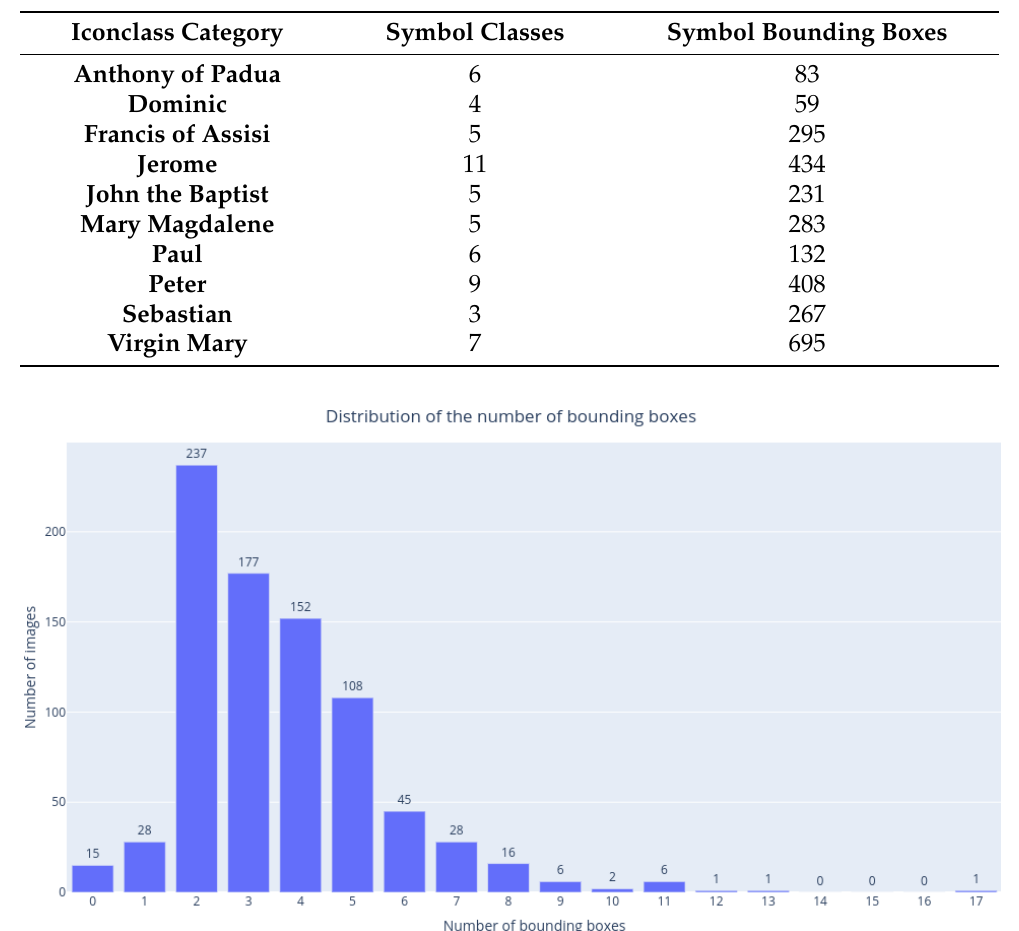
Figure 4. Bounding box distribution: most images contain from 2 to 5 bounding boxes (average =